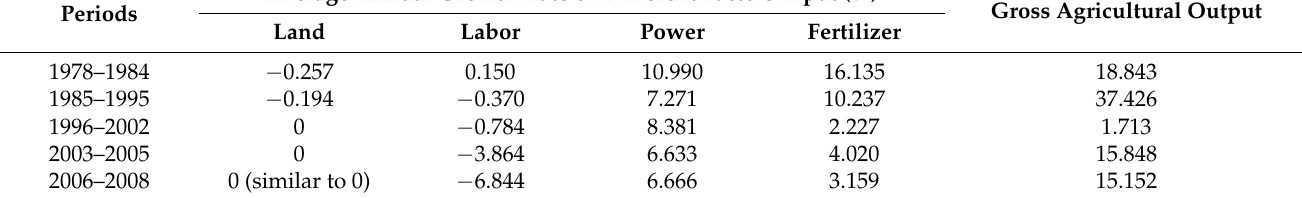
Table 3. Average annual growth rate of different factors input and gross agricultural output in each